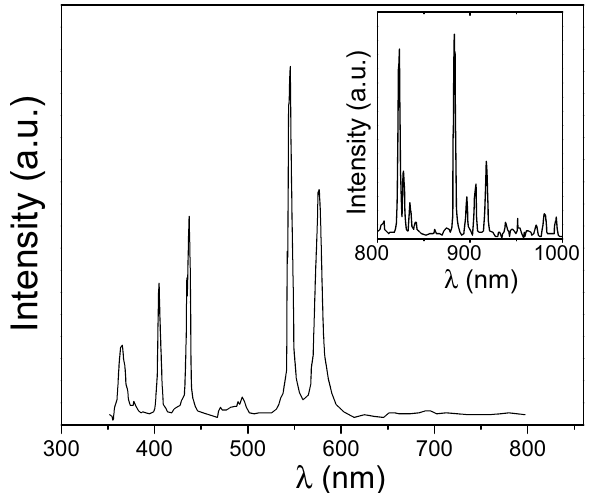
Figure A2. The experimentally-determined spectrum of the mercury–xenon UV lamp employed for the polymerization procedures. Main panel: short wavelength part of the spectrum, dominated by the Hg peaks. Inset: long wavelength part of the spectrum, dominated by the Xe